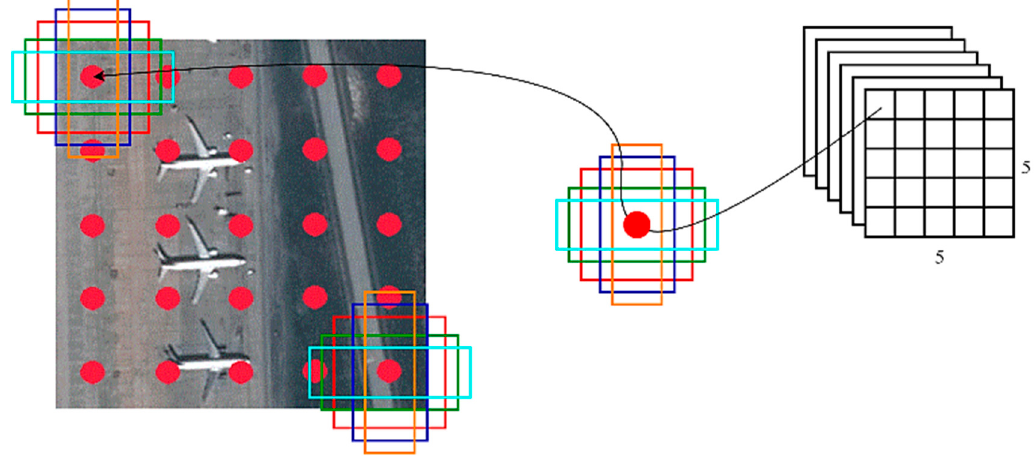
Figure 5. Illustration of the 5x5 feature map and generated default boxes with six aspect ratios.